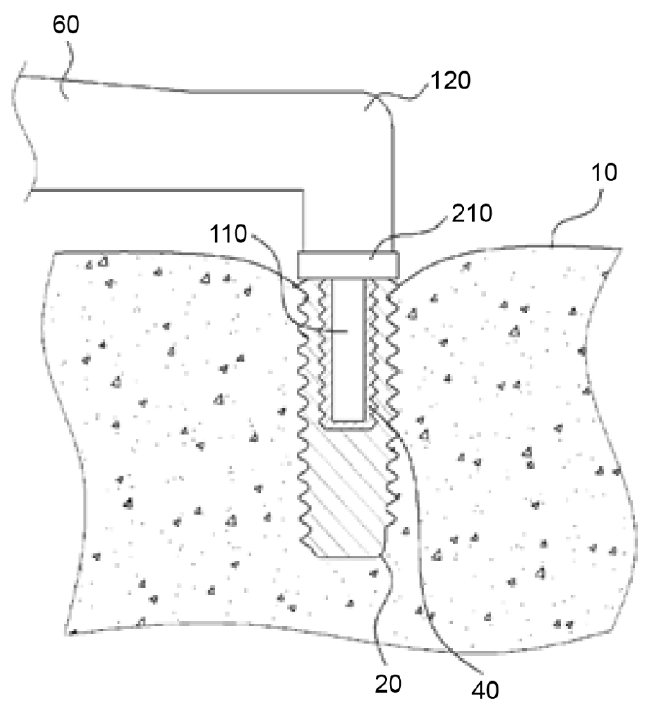
Figure 1. Handpiece (60) with a heating unit (120), temperature sensor (210), and connecting device (110). The heating unit provides heat between 40 °C and 1000 °C. The temperature sensor measures the temperature of the implant (20) and surrounding tissues (10). Source: [51].